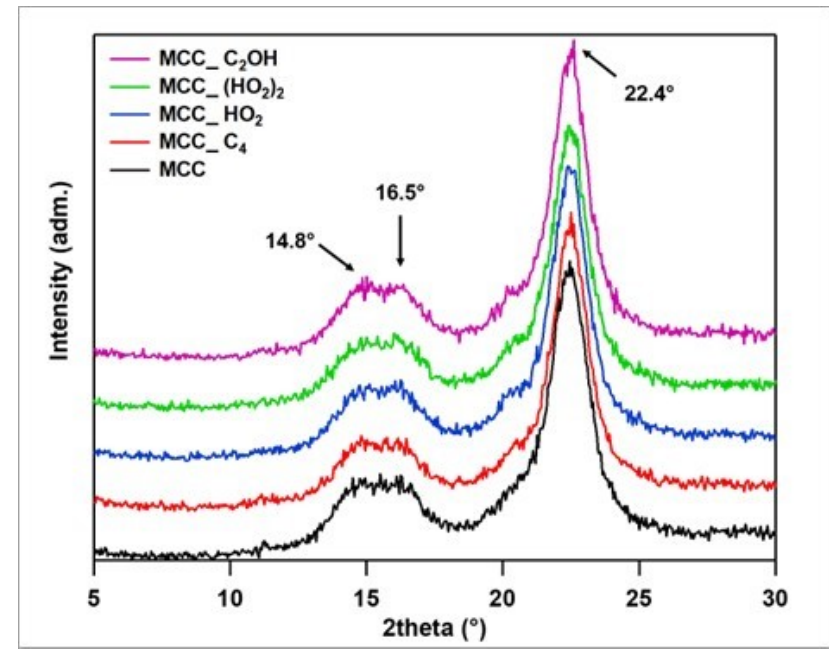
Figure 2. Diffractograms for the unmodified and IL-modified MCC.